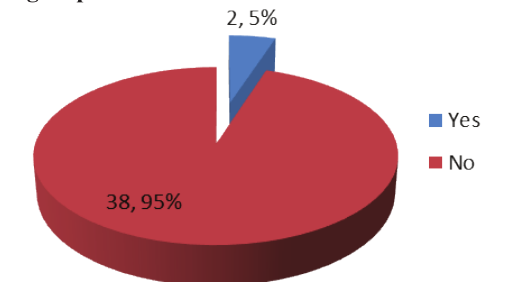
Figure-II: Presence of Body rash among patients of the intravenous Ferric Carboxymaltose